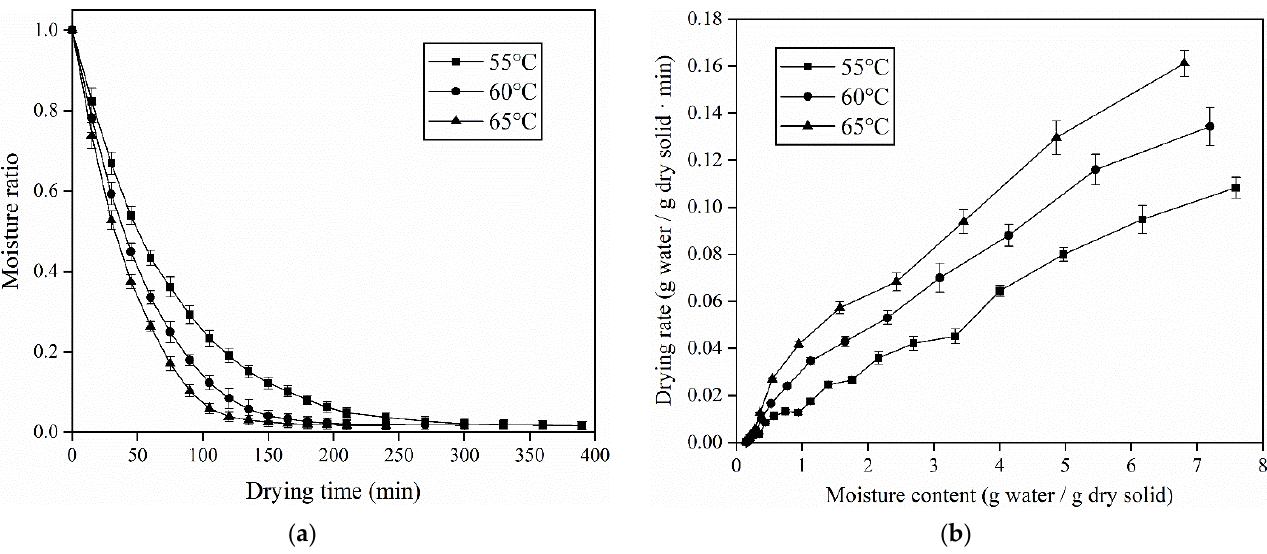
Figure 2. Moisture ratio ( a ) and drying rate ( b ) curves of cantaloupe slices under different SMIR drying temperatures (slice thickness 7 mm, radiation distance 120 mm).